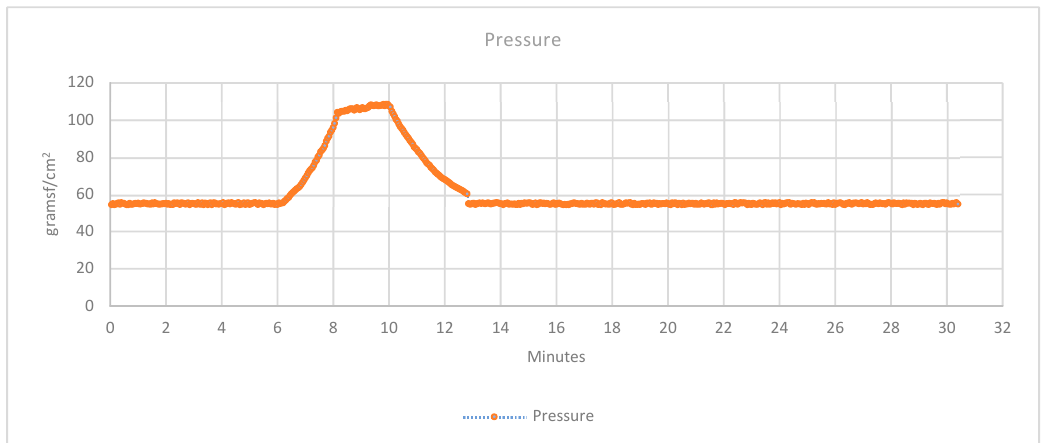
Figure 13. Collected data of the pressure sensor 3.2.4 Presence.